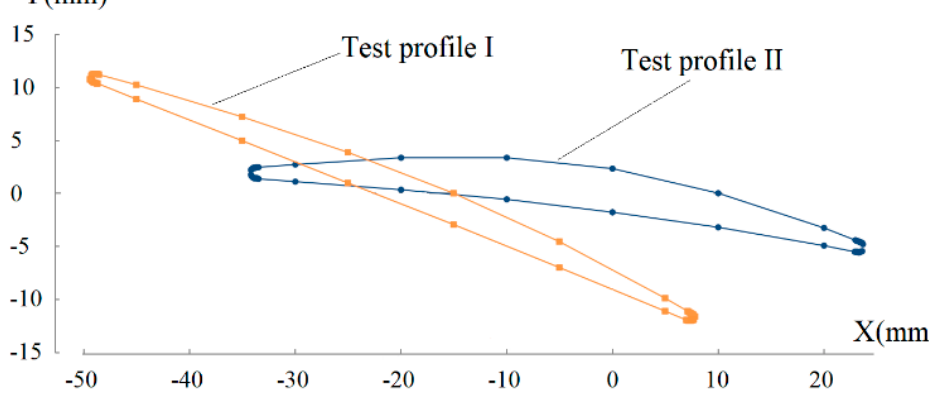
Figure 10. Measurement curves of test profiles on JE42.